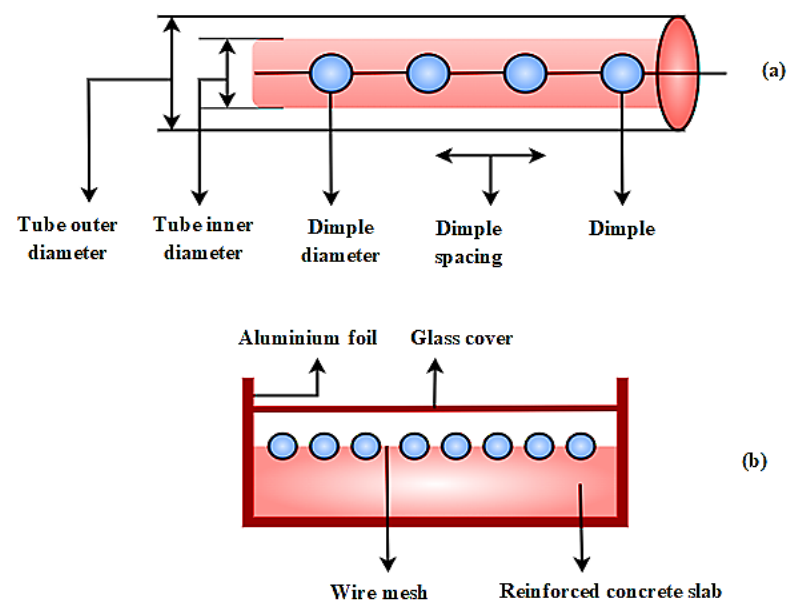
Figure 2. ( a ) Dimpled tube and ( b ) a concrete slab’s Figure 2 . ( a ) Dimpled tube and ( b ) a concrete slab ’ s cross-section .